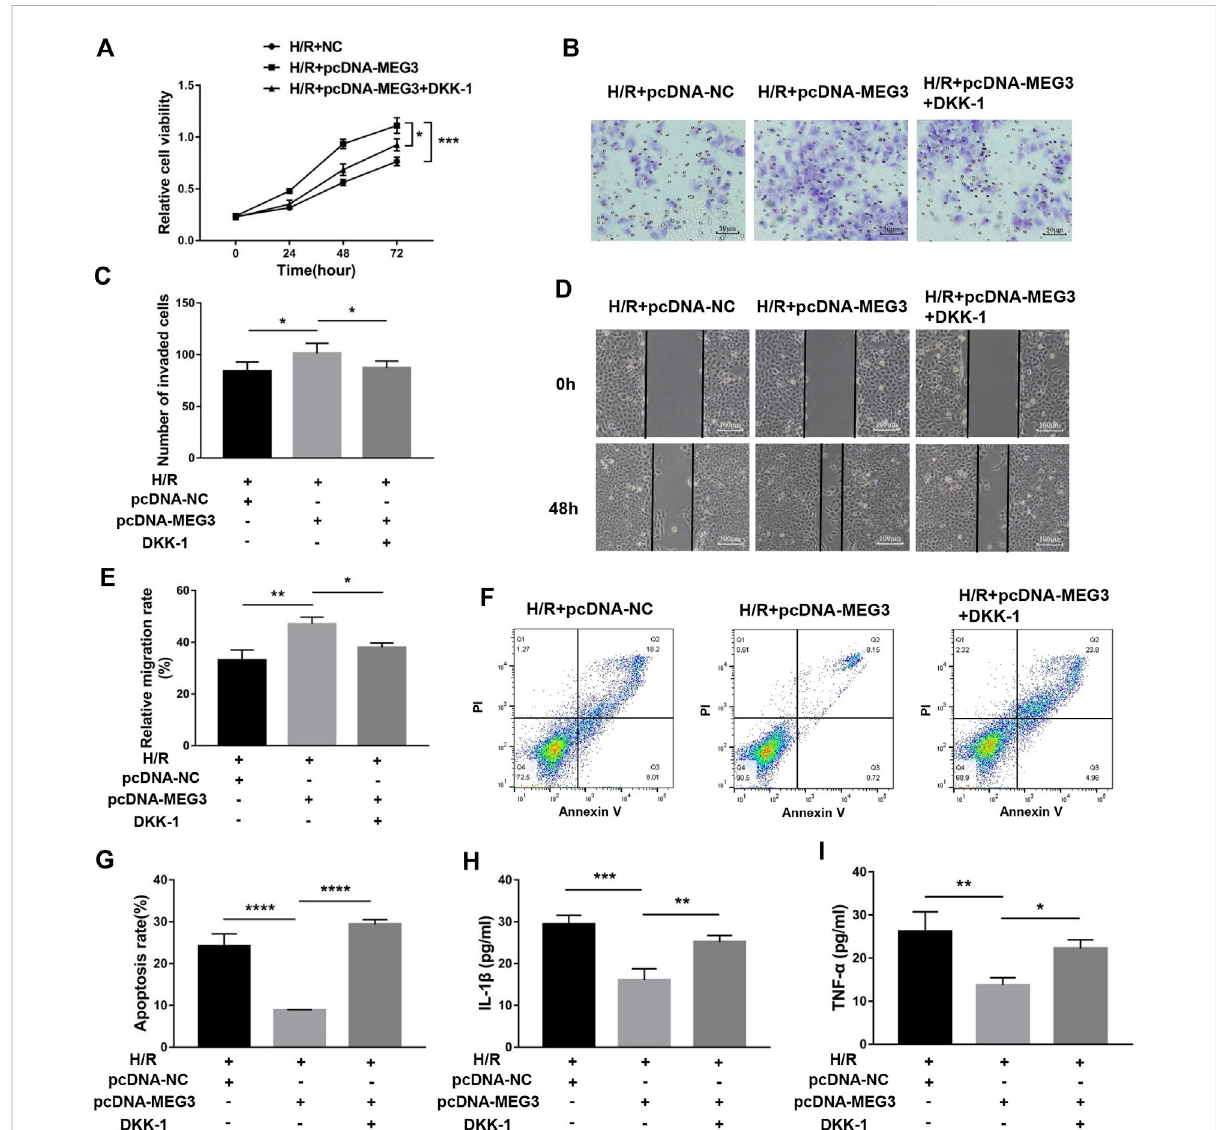
FIGURE 7 Blocking Wnt/ β -Catenin signaling disrupted the effect of MEG3 on trophoblast function. (A) Cell proliferation was determined by CCK-8 assay. (B,C) Cellinvasionabilitywasdeterminedbytranswellassay. (D,E) Cellmigrationabilitywasdeterminedbyscratchassay. (F,G) Theapoptosisratewas measured by fl ow cytometry. ELISA was used to measure IL-1 β (H) and TNF- α (I) levels in the cell supernatant. n = 3/group. * p < 0.05; ** p < 0.01; *** p < 0.001; **** p <